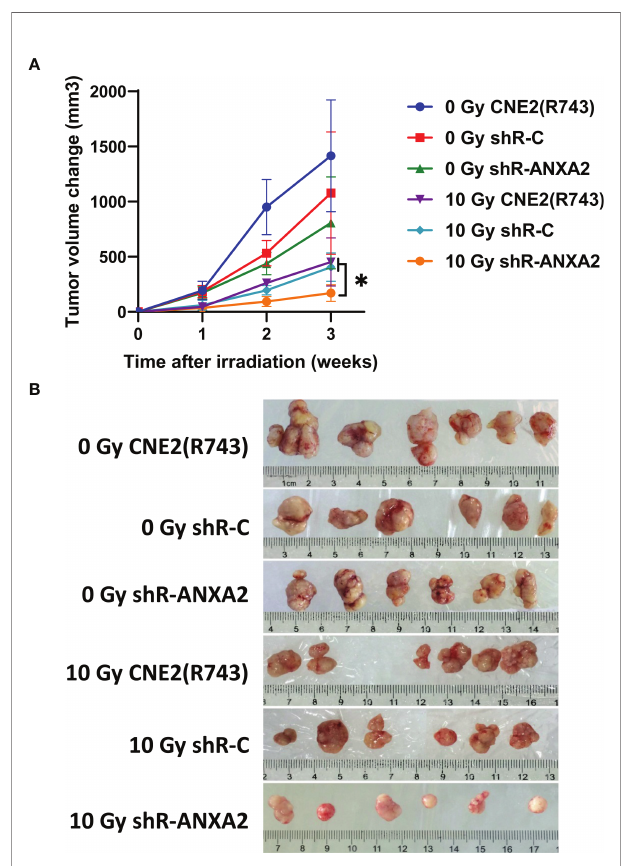
FIGURE 8 | Knockdown of ANXA2 expression increases the radiosensitivity of xenografted tumors in a nude mice model of NPC. (A) the volumes of the xenografted tumors from shR-ANXA2, shR-C and CNE2(R743) 1, 2 and 3 weeks post-irradiation at doses of 0 and 10 Gy; (B) the size of the xenografted tumors from shR-ANXA2, shR-C and CNE2(R743) 3 weeks post-irradiation at doses of 0 and 10 Gy. Values are presented as mean ± SD. * P <